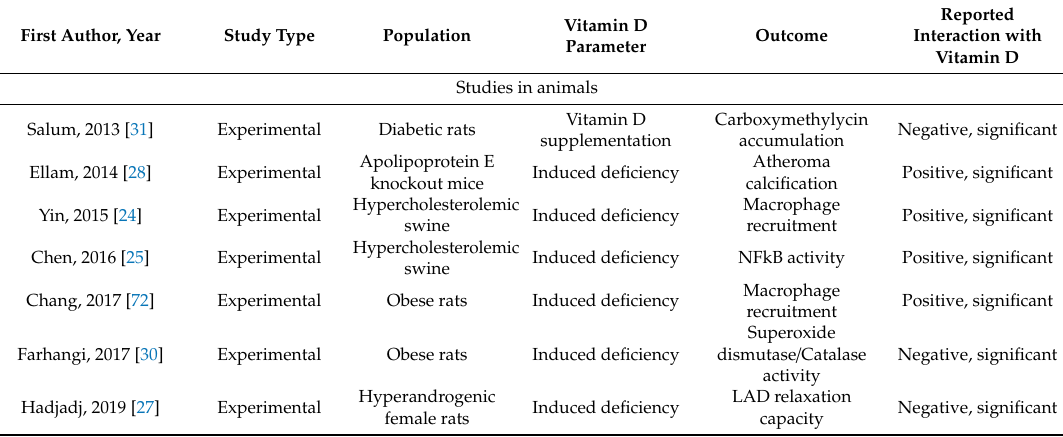
Table 1. E ff ects of Vitamin D on vascular health in various studies of animal models and clinical